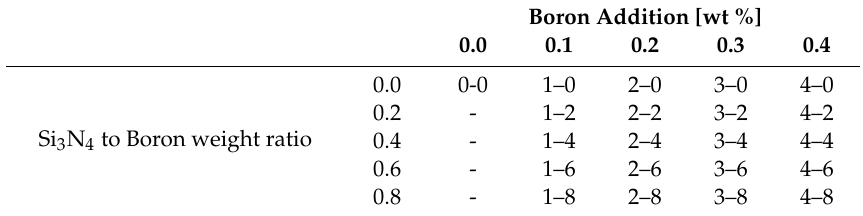
Table 3. Description of samples. For the convenience of the reader, the first digit describes the amount of boron added in tenths of a percent while the second digit describes the weight relation of Si 3 N 4